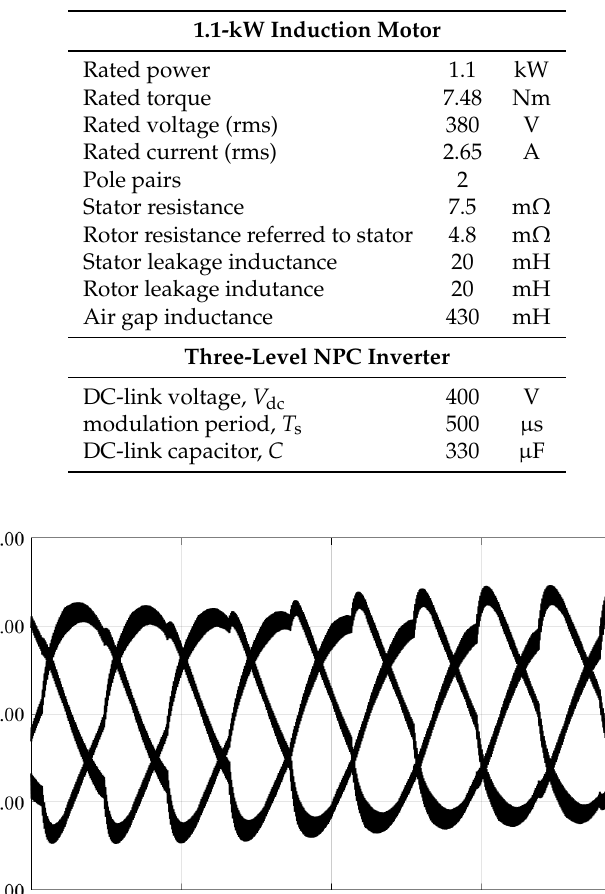
Table 2. Parameters of the electrical drive.